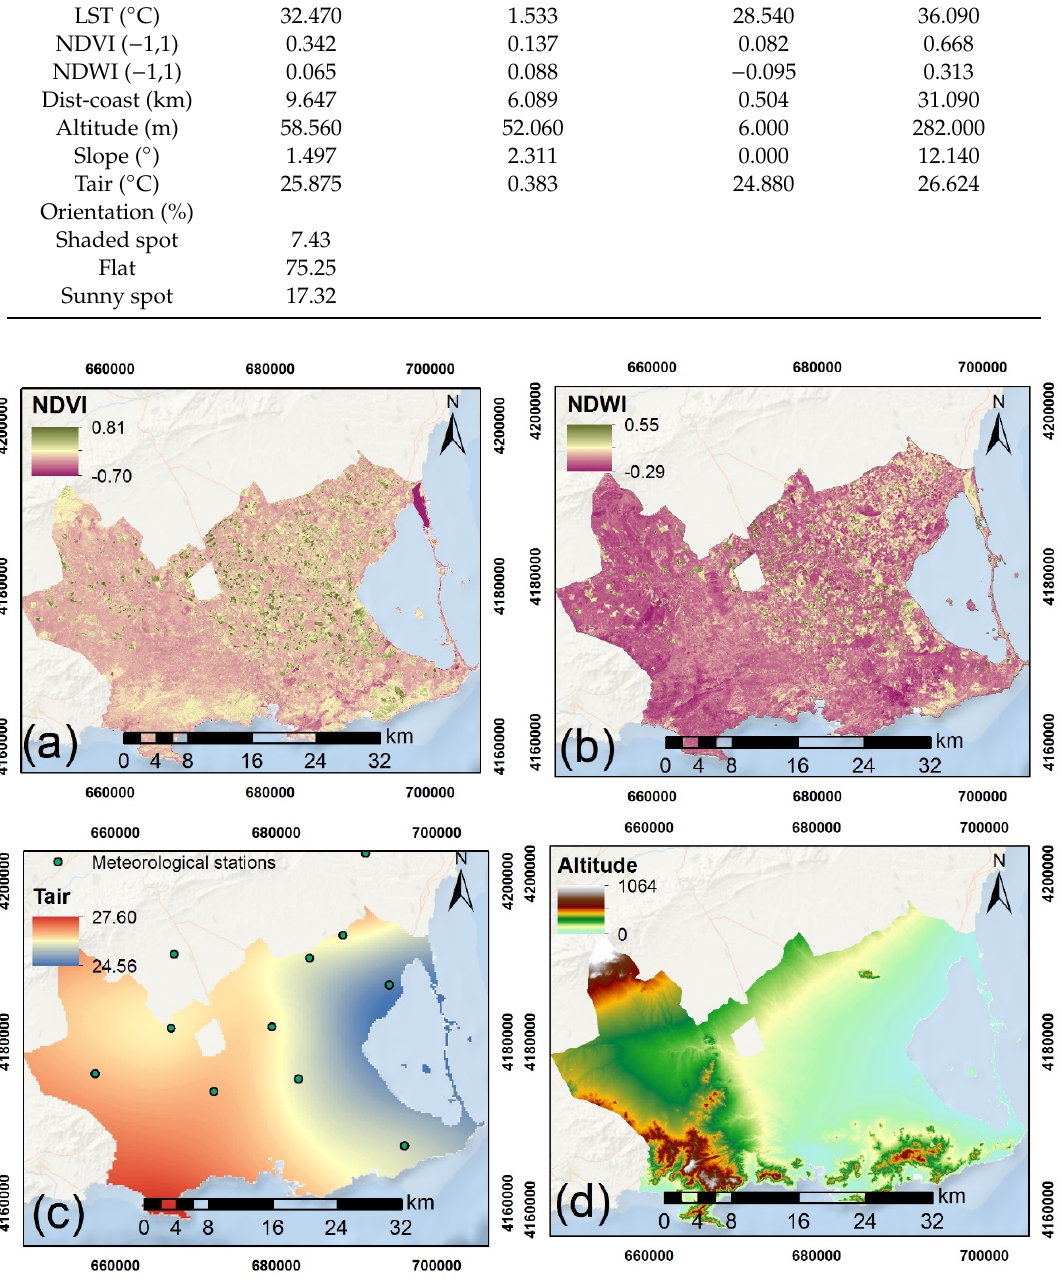
Figure A1. Spatial distribution of factors: NDVI ( a ), NDWI ( b ), Tair ( c ), Altitude ( d ), Slope ( e ), and Orientation ( f ).